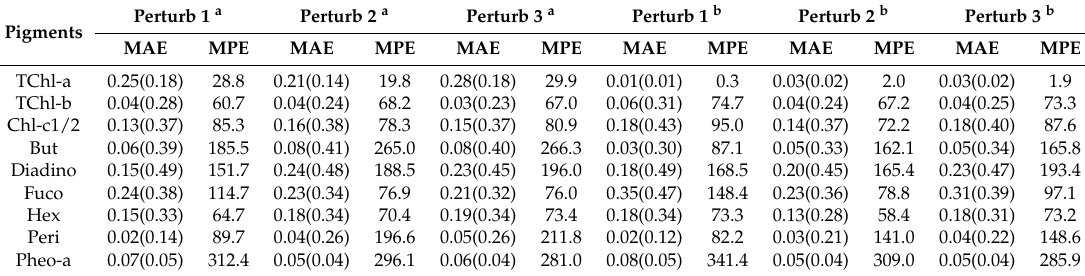
Table 6. Statistics of phytoplankton pigment retrieval using SVD-NNLS-9 with a ph ( λ ) at ten MODIS bands based on leave-one-out cross-validation. MAE is in mg m − 3 (values outside the parentheses were calculated with linear-scale values, while inside the parentheses with log10-scale values) and MPE in %. “Perturb 1, 2 and 3” represent the input data with perturbations of pigment concentrations solely, a ph ( λ ) solely and both,